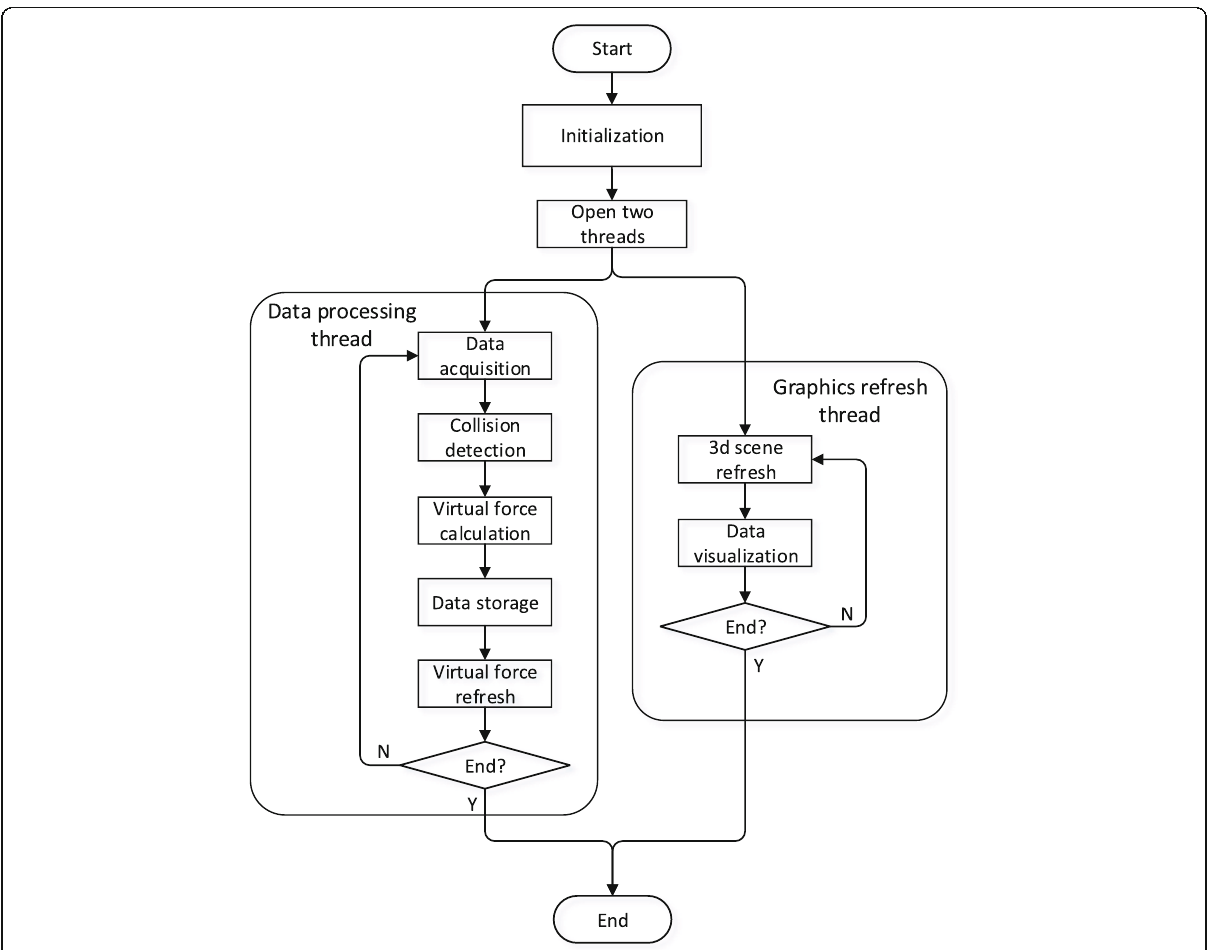
Fig. 5 Flow chart of the software for haptic